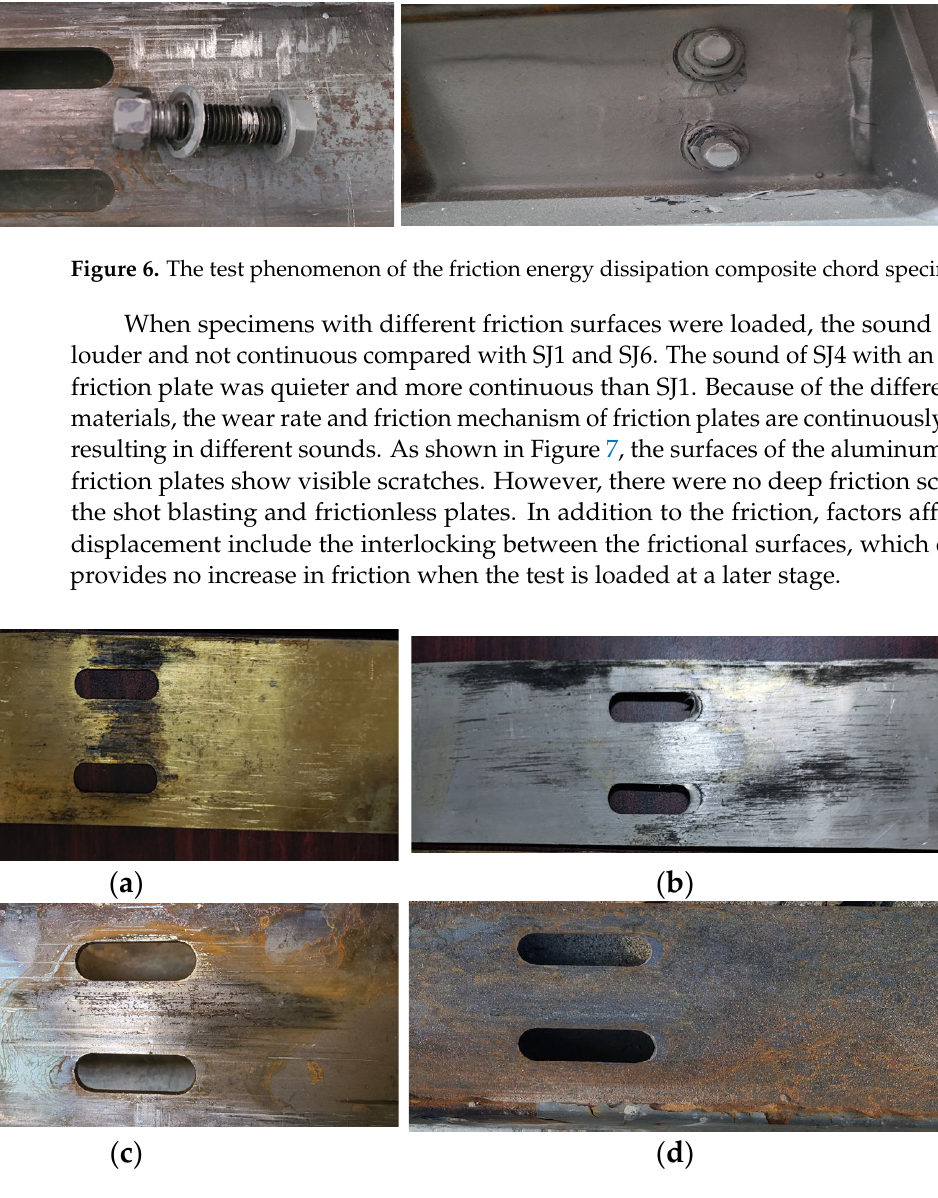
Figure 6. The test phenomenon of the friction energy dissipation composite chord specimens.